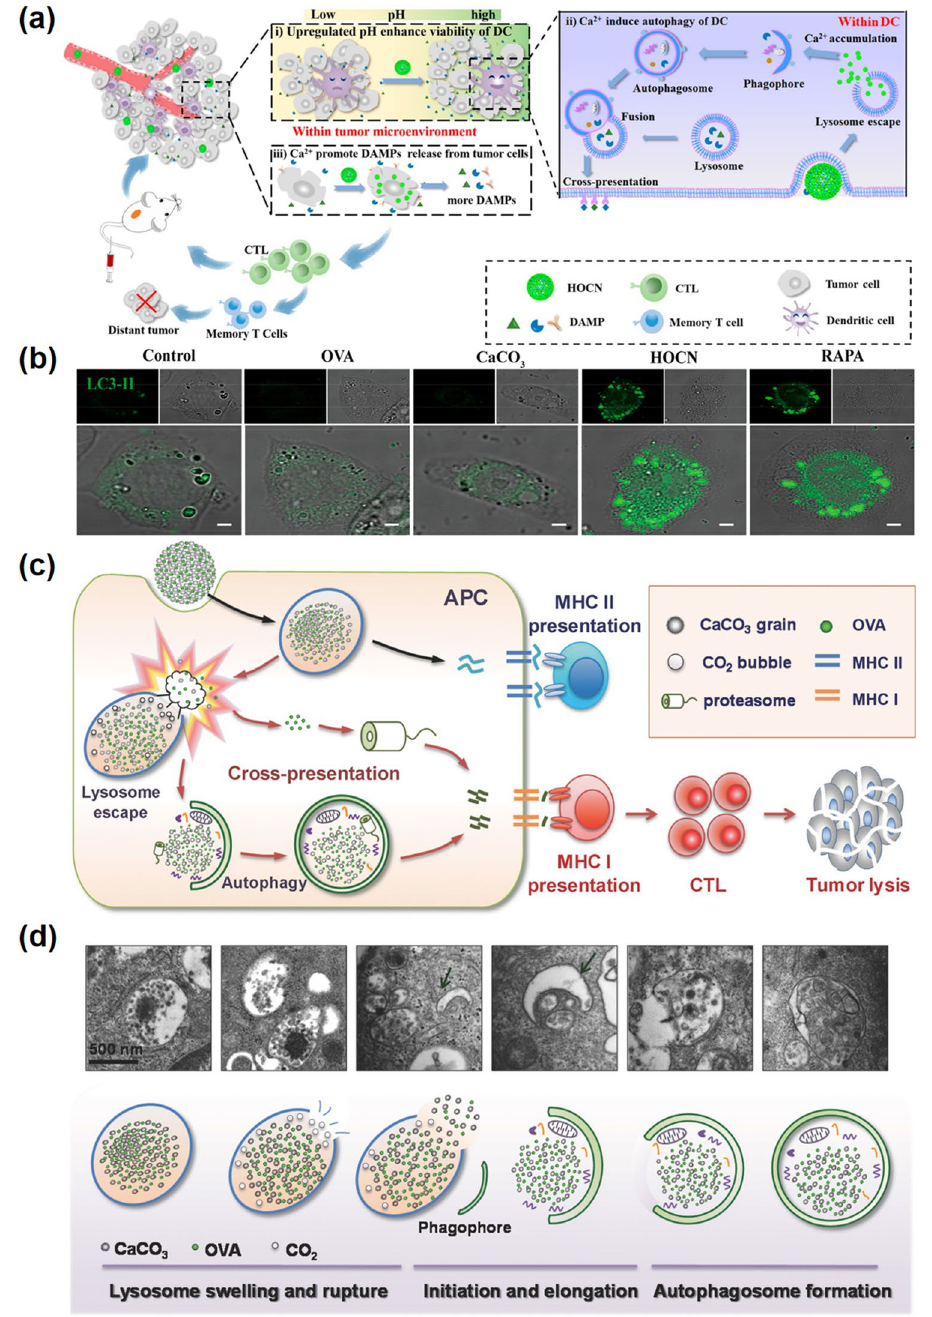
Fig. 11 Ca-NMs-induced autophagy. a Schematic illustration of HOCN enhancing mitoxantrone (MTX)-mediated chemo-immunotherapy by breaking multiple barriers of DCs antigen cross-presentation. b Expression level of LC3-II in DCs [145]. Copyright 2020, American Chemical Society. c Illustration of OVA@NP-associated autophagy mediated antigenic cross presentation. d TEM images and relevant schemes illustration of autophagy [146]. Copyright 2018,